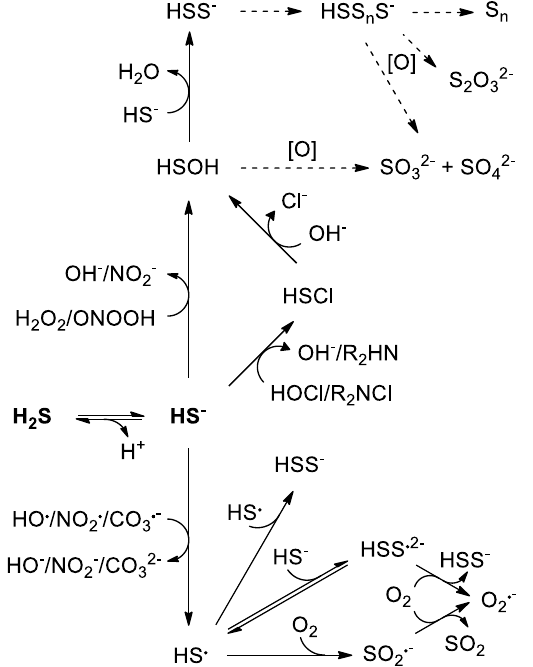
Scheme 1. Hydrogen sulfide oxidation by reactive species. The dashed lines represent processes that are accomplished in more than one step. Protons are sometimes omitted for simplicity.